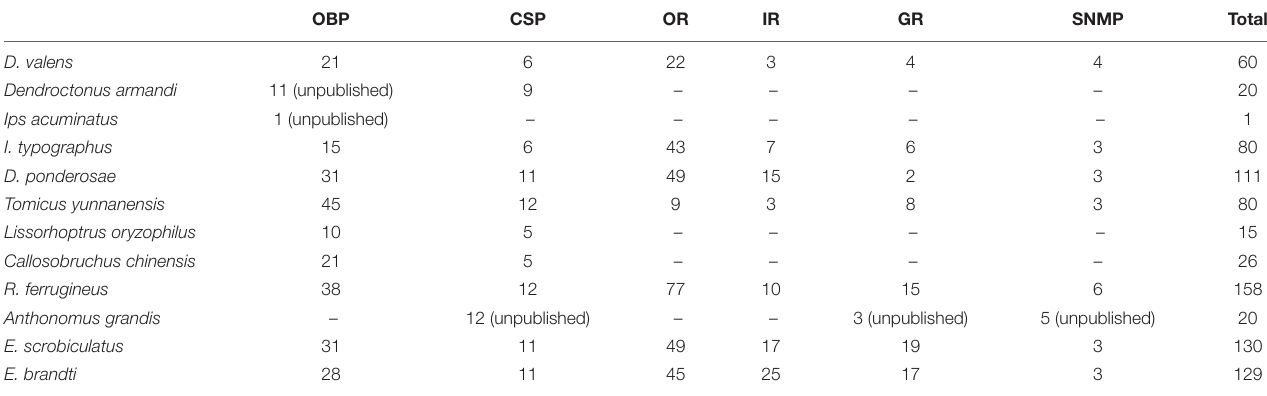
TABLE 1 | The number of odorant binding protein (OBP), chemosensory protein (CSP), odorant receptor (OR), ionotropic receptor (IR), gustatory receptor (GR), and sensory neuron membrane protein (SNMP) in Curculionoidea. OBP CSP OR IR GR